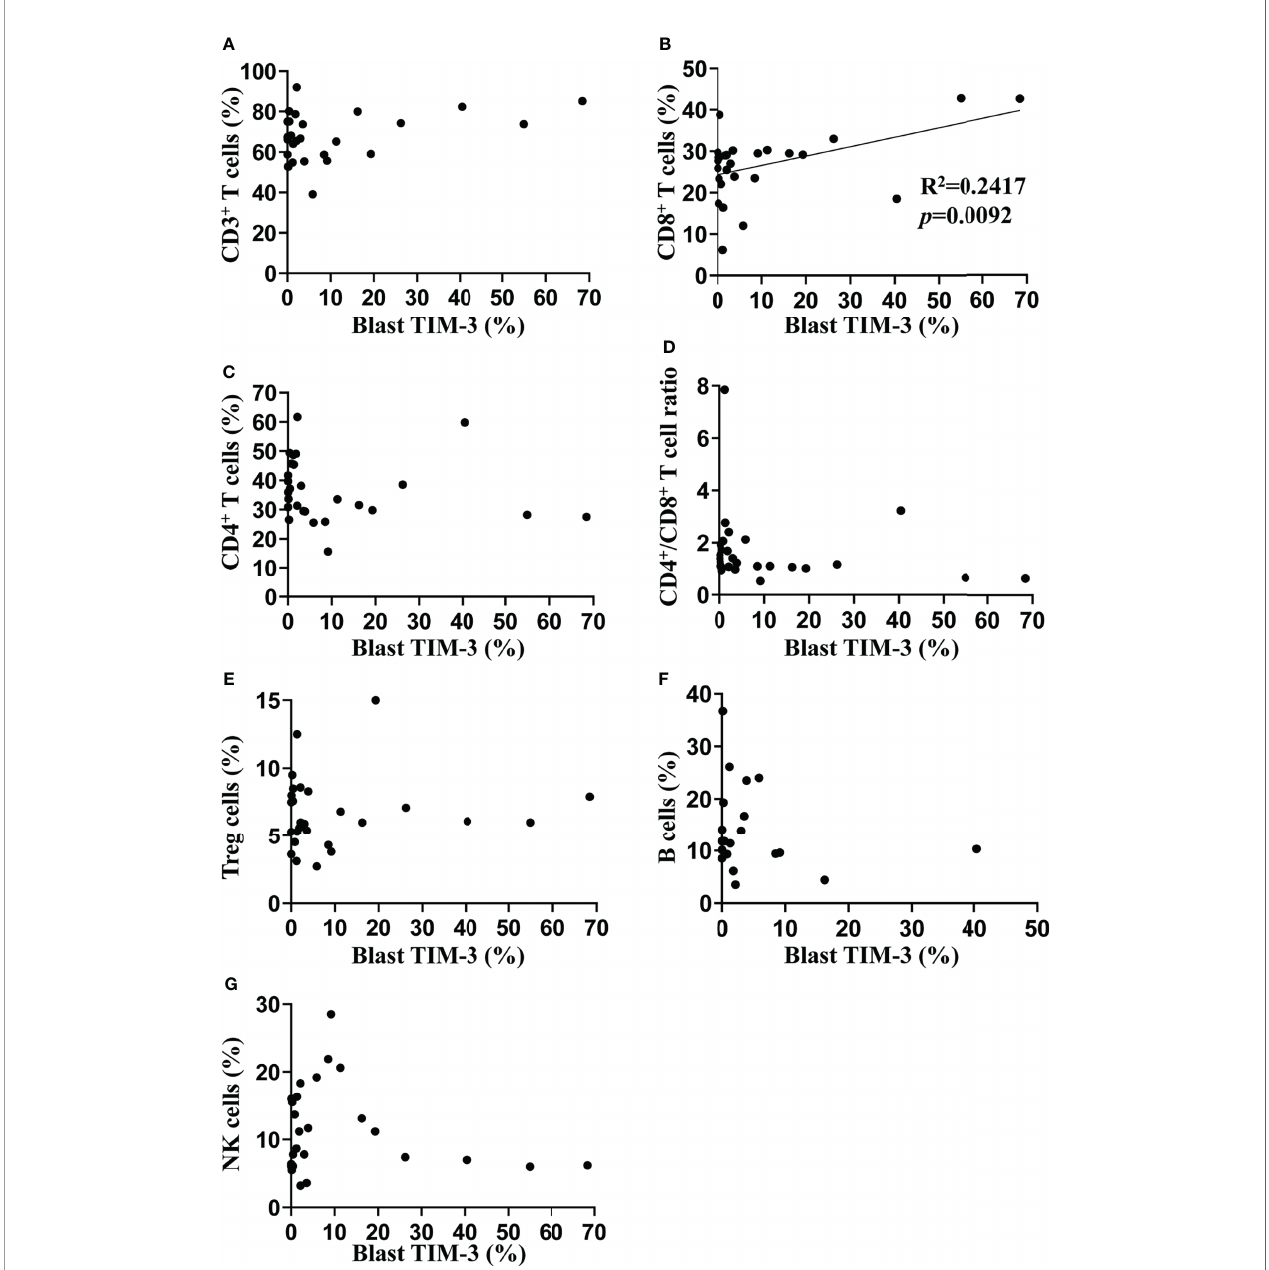
FIGURE 2 | Associations of TIM-3 expression level of leukemic blasts with proportions of peripheral lymphocyte subtypes in AML patients. Proportions of multiple lymphocyte subsets were assessed in 27 out of 34 AML patients using fl ow cytometry (the percentage of B cells was only available in 20 patients). Linear regression was performed to determine associations of TIM-3 expression level of leukemic blasts with percentages of CD3 + T cells (A) , CD3 + CD8 + T cells (B) , CD3 + CD4 + T cells (C) , CD4 + CD25 + CD127 - Treg cells (E) , CD19 + B cells (F) and CD16 + or CD56 + NK cells (G) , as well as the ratio of CD4 + /CD8 + T cells (D)